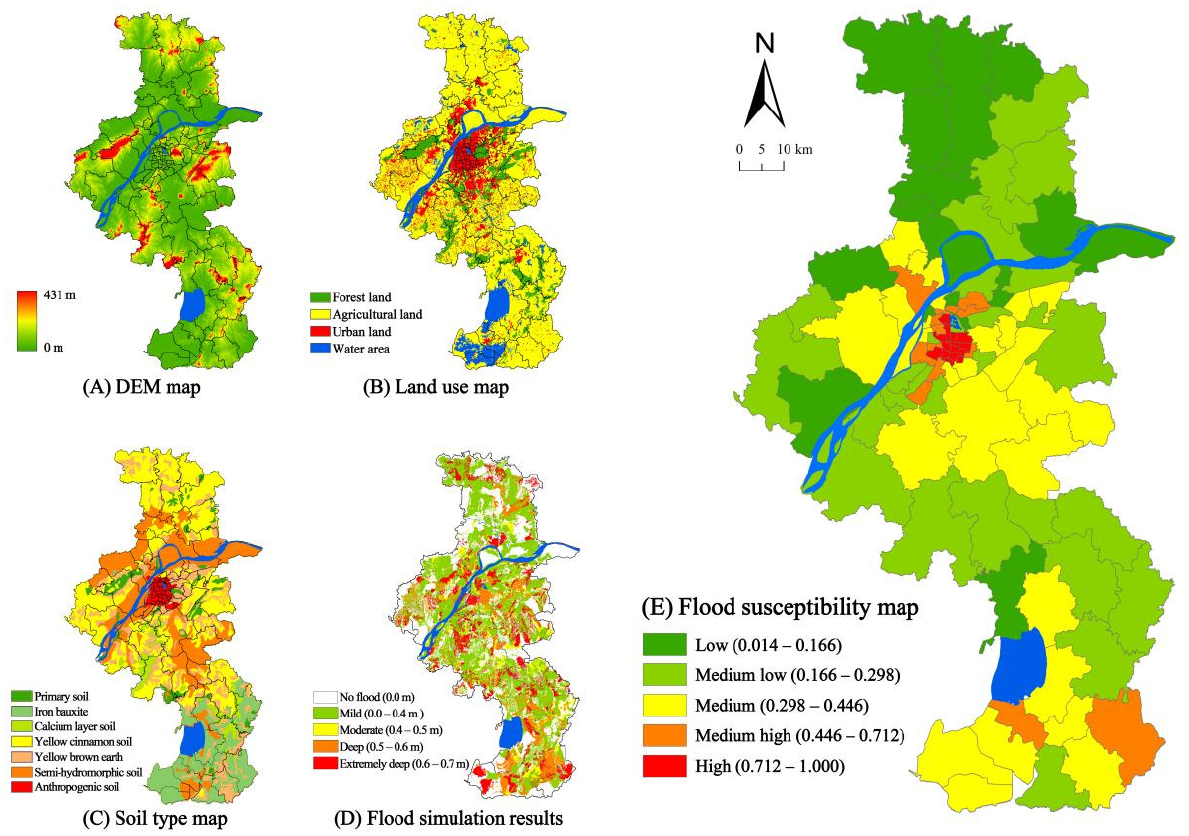
Figure 6. Simulation process of flood susceptibility.